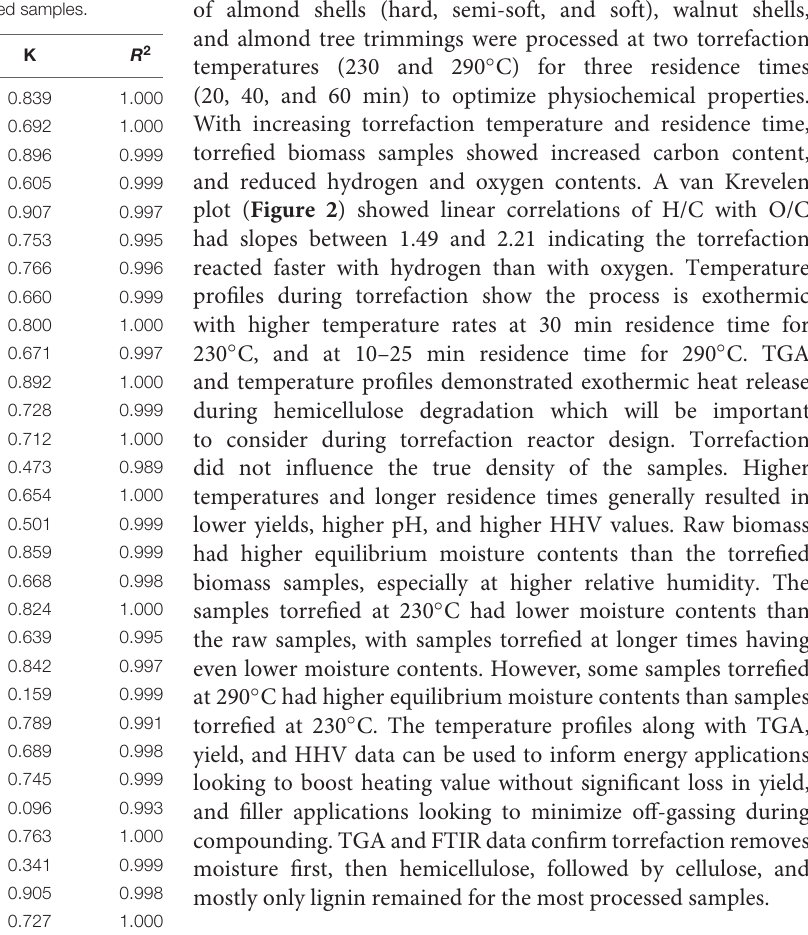
TABLE 3 | GAB parameter and R 2 values for raw and torrefied